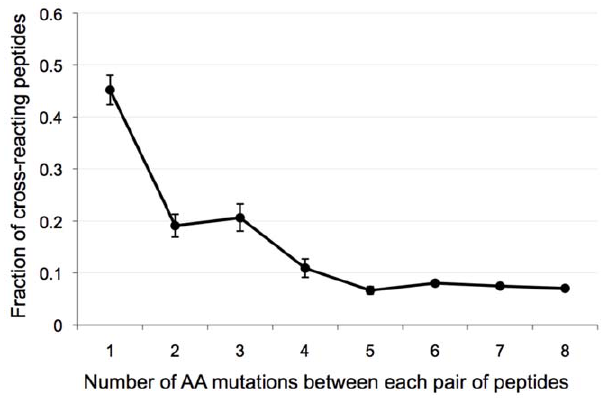
Figure 7. Cross-reactivity among HIV-1-B Nef peptides. The fraction of peptides that cross-react is represented as a function of the number of AA differences between the two peptides. For a pair of peptides (with the same HXB2 coordinates), the fraction of peptides that cross-react corresponds to the number of individuals who recognized both peptides divided by the number of individuals who recognized the more common one.